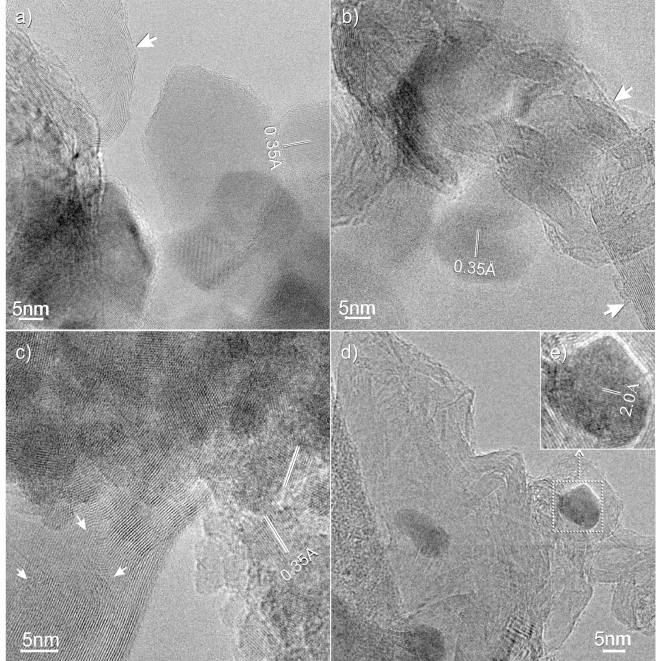
Figure 6. HRTEM images of Fe-titanate nanotubes prepared from: ( a , b ) 0.0025 M, ( c , d ) 0.01 M Fe(NO 3 ) 3 solutions; ( e ) high-resolution image of the region selected in ( d ), after the thermal decomposition of C 2 H 4 at 750 ◦ C for 1 (cid:48) . The arrows highlight the graphitic domains at the interface with TiO 2 nanoparticles ( a – c ) and carbon-encapsulated nanoparticles ( d